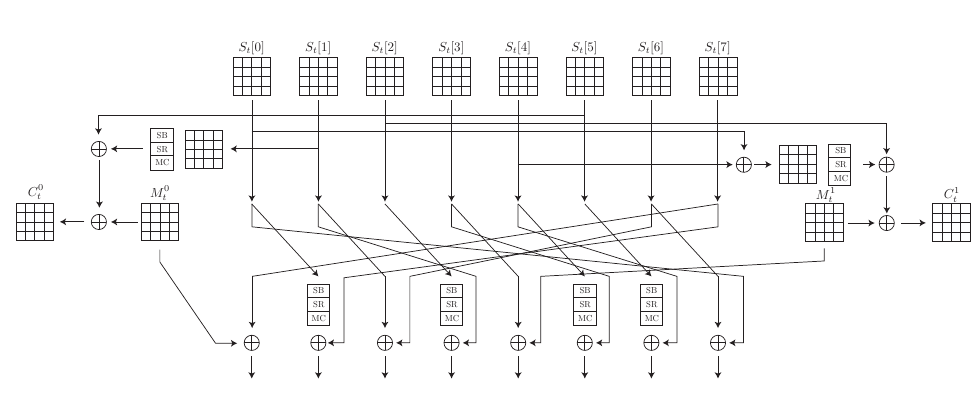
Figure 1: The update function of Rocca